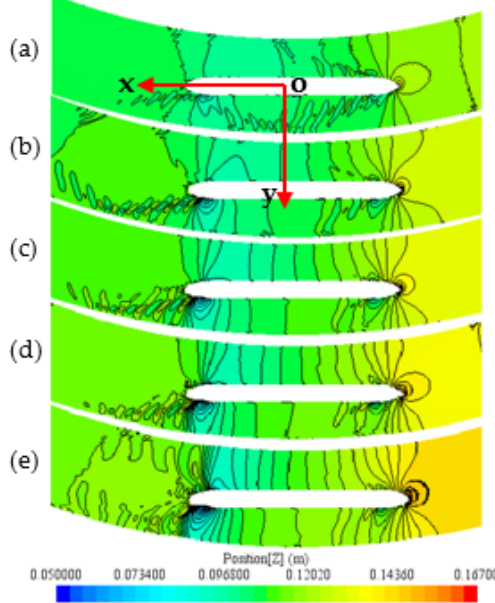
Figure 19. Free surface elevation contours of current velocity. ( a – e ): current velocity = 0 m/s, 0.1 m/s, 0.15 m/s, 0.2 m/s, 0.25 m/s.